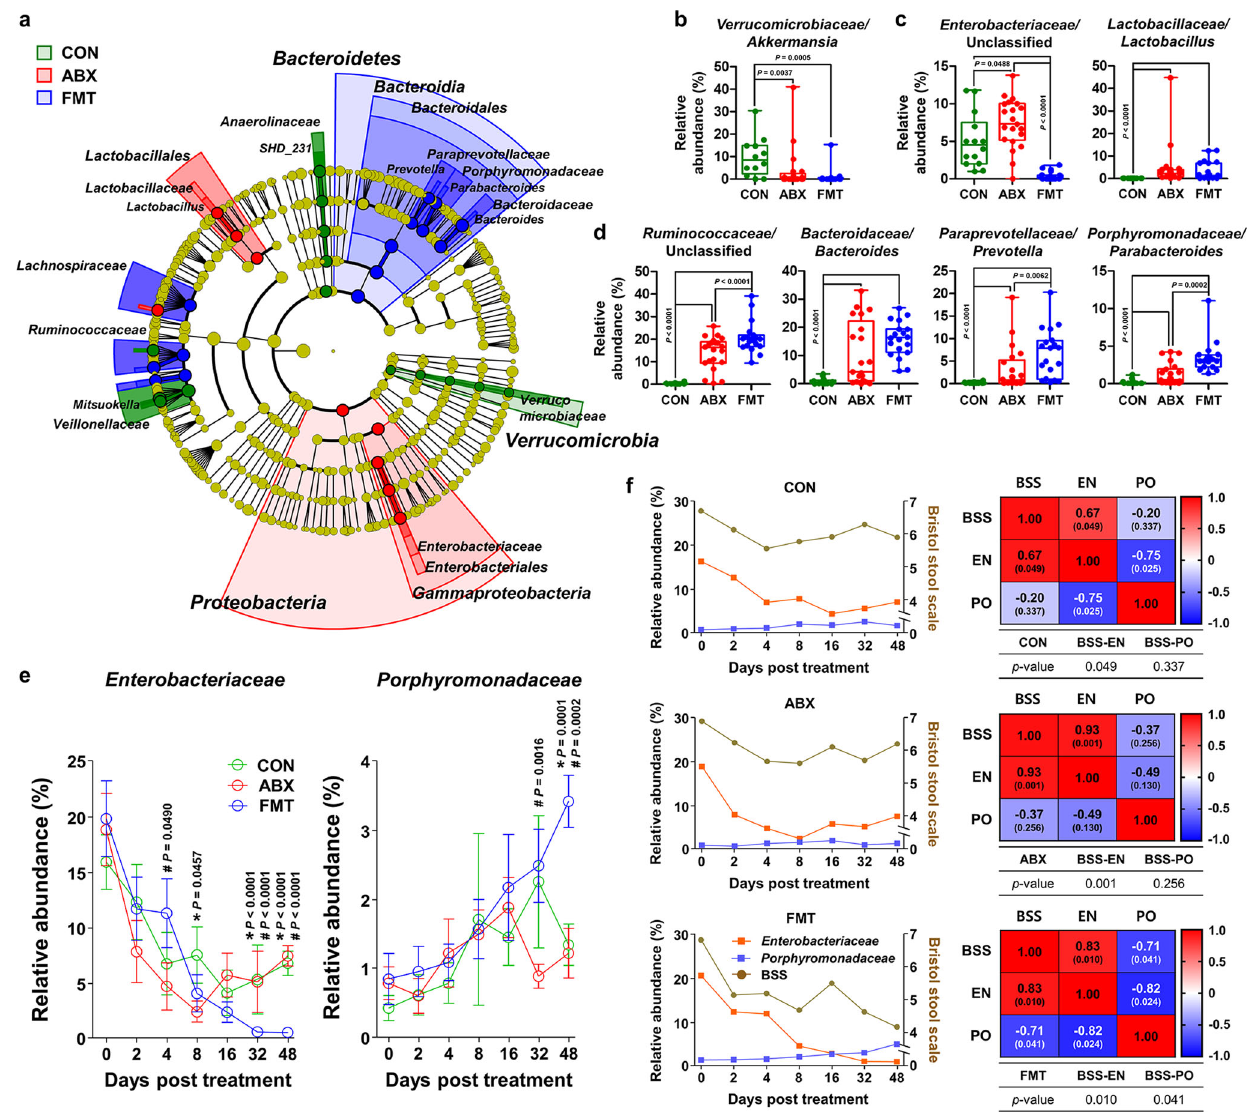
Fig. 3 Discriminating microbial taxa associated with the incidence of diarrhea, and correlation analysis of gut Enterobacteriaceae or Porphyromonadaceae with the incidence of diarrhea. a The linear discriminant analysis effect size (LEfSe) circular cladogram generated from the day 48 metataxonomic data identi fi ed the discriminating taxa for the CON ( n = 14), ABX ( n = 23), and FMT ( n = 20) groups (shown in different colors). b – d Relative abundance of the predominant taxa in ASV feature table compiled using the SILVA database for the CON ( b , n = 14), ABX ( c , n = 23), and FMT ( d , n = 20) groups, presented as bar charts and dot plots. The lines, boxes, and whiskers in the box plots represent the median, and 25th, and 75th percentiles, and the min-to-max distribution of replicate values, respectively. Data are shown as mean ± SEM and were analyzed using the Mann – Whitney U test (two-tailed). e Changes in the relative abundance of the family Enterobacteriaceae (left) and Porphyromonadaceae (right) with time (CON, n = 14; ABX, n = 23; FMT, n = 20). Data are shown as mean ± SEM. The P values were determined using the Mann – Whitney U test (two-tailed). *Comparison of the CON and FMT groups; #comparison of the ABX and FMT groups; and † comparison of the CON and ABX groups. f The relative abundances of the families Enterobacteriaceae (left y -axis, orange) and Porphyromonadaceae (left y -axis, blue), and the BSS (right y -axis, brown) in each group over time (left panel). The Pearson correlation coef fi cients for multiple variants and statistical signi fi cance (two-tailed) for the relationships among BSS and the relative abundances of the families Enterobacteriaceae and Porphyromonadaceae were calculated (right panel). CON control, ABX antibiotic, FMT fecal microbiota transplantation, BSS Bristol stool scale, EN Enterobacteriaceae , PO Porphyromonadaceae . Source data are provided as a Source Data fi